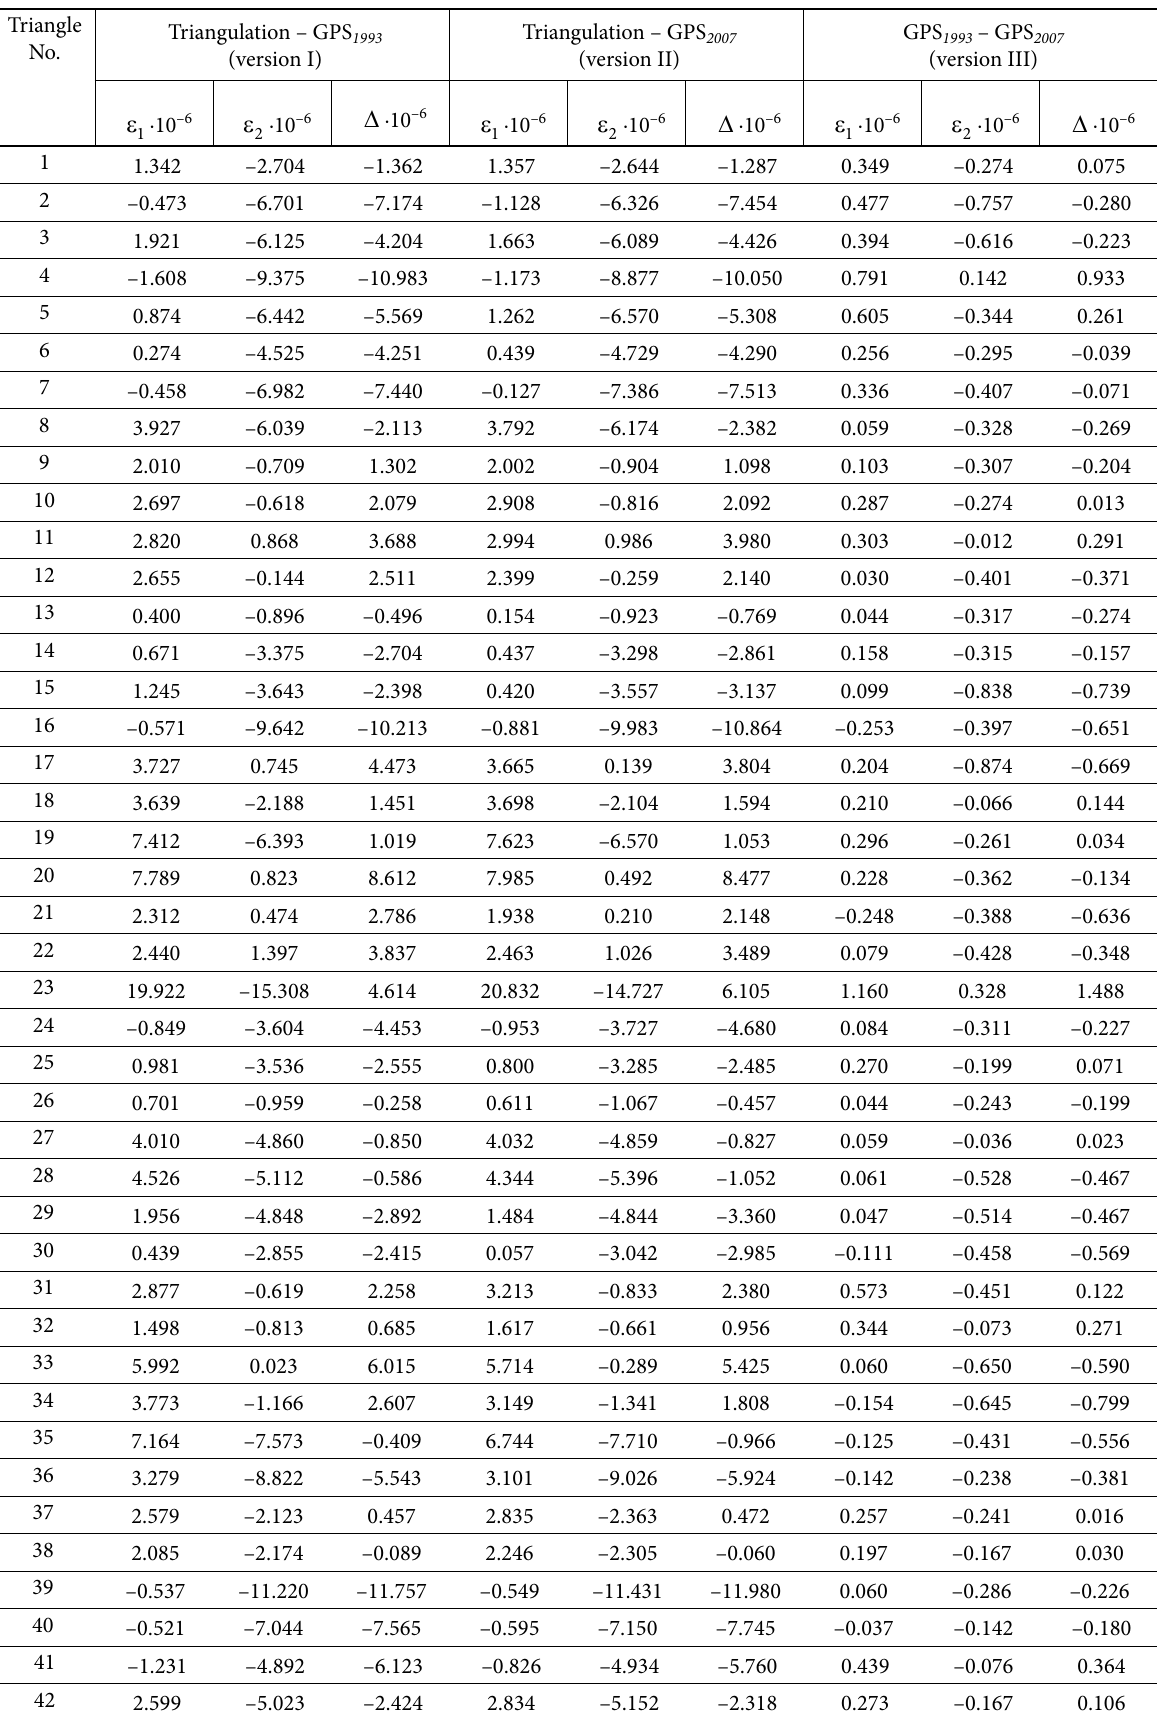
Table 1. Characteristics of the Earth’s crust horizontal deformations